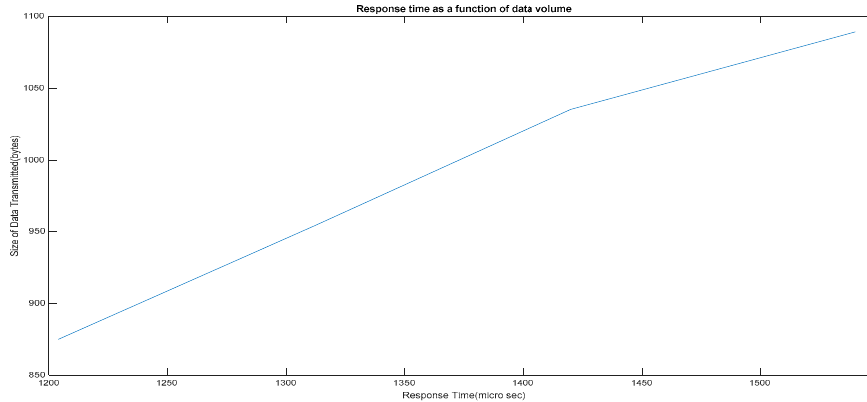
Figure 2. Time to response vs. routes.